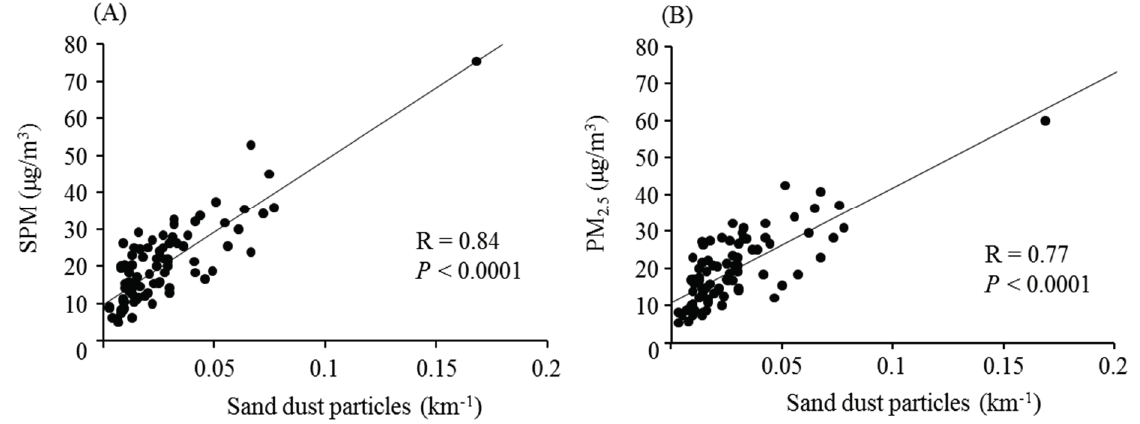
Figure 3. Associations of sand dust particles with SPM and PM 2.5 Sand dust particles were significantly associated with suspended particulate matter (SPM) ( A ) and particulate matter <2.5 μ m (PM2.5) ( B ).